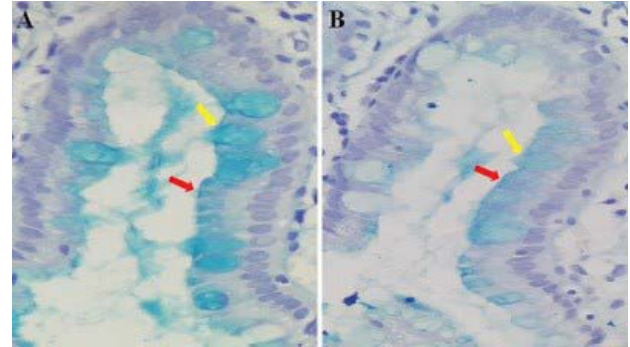
fIGuRE 2 – Presence of sialo or sulfomucins in the Goblet and Columnar cells with Alcian Blue at pH 2.5 (A). Confirmation of sulfomucins in the Goblet cells with Alcian Blue at pH 0.5 but Columnar cells not (B). Interpretation of the algorithm: Intestinal Metaplasia- Type II. Red arrow: Columnar Cell. Yellow arrow: Goblet cell. Objective: 40X.